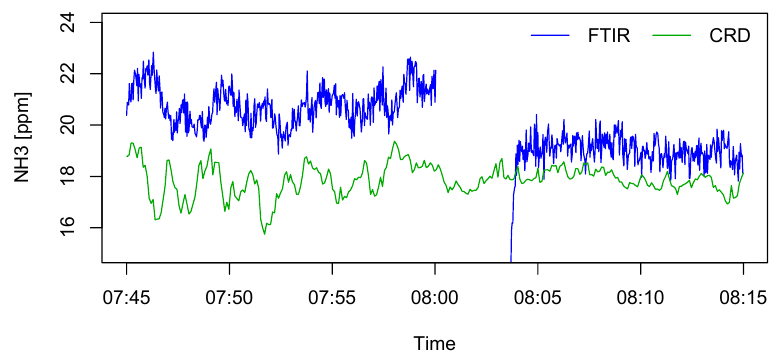
Figure 10. Offset shift of the Fourier transform infrared (FTIR) spectroscopy gas analyzer after zero calibration at 8:00. Comparative measurements were provided by a cavity ring-down (CRD) spectroscopy